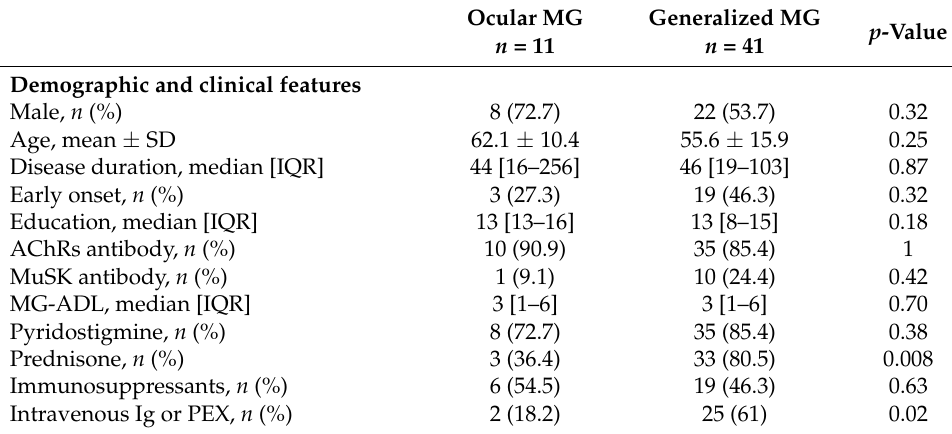
Table 3. Differences between patients with Ocular and Generalized